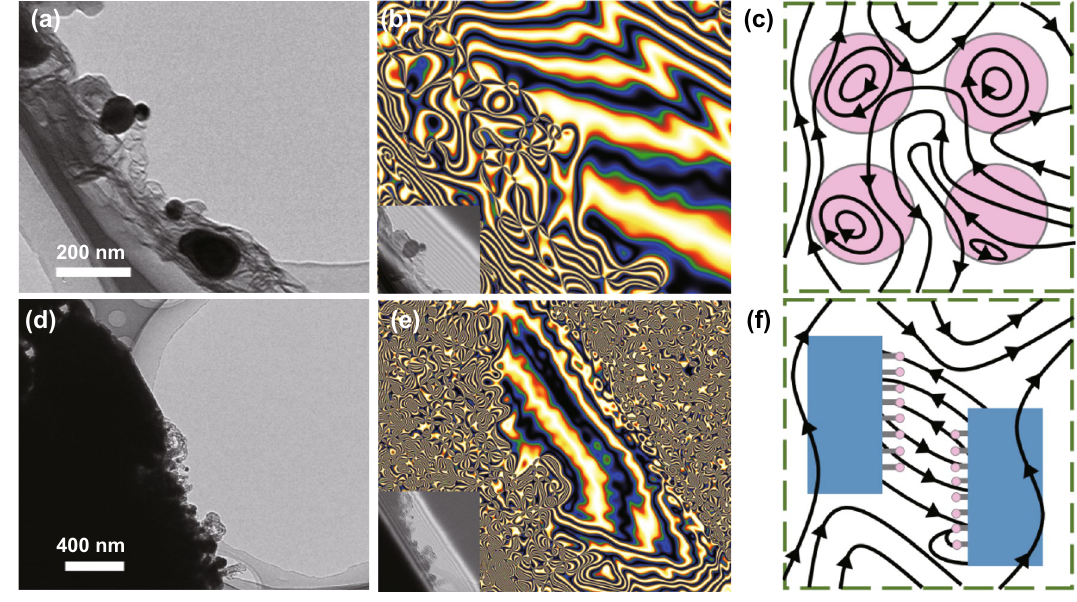
Fig. 6 a TEM image, b corresponding off-axis electron holograms and c corresponding magnetic coupling network of CNTs/Ni. d TEM figure, e corresponding off-axis electron holograms and f corresponding magnetic coupling network of